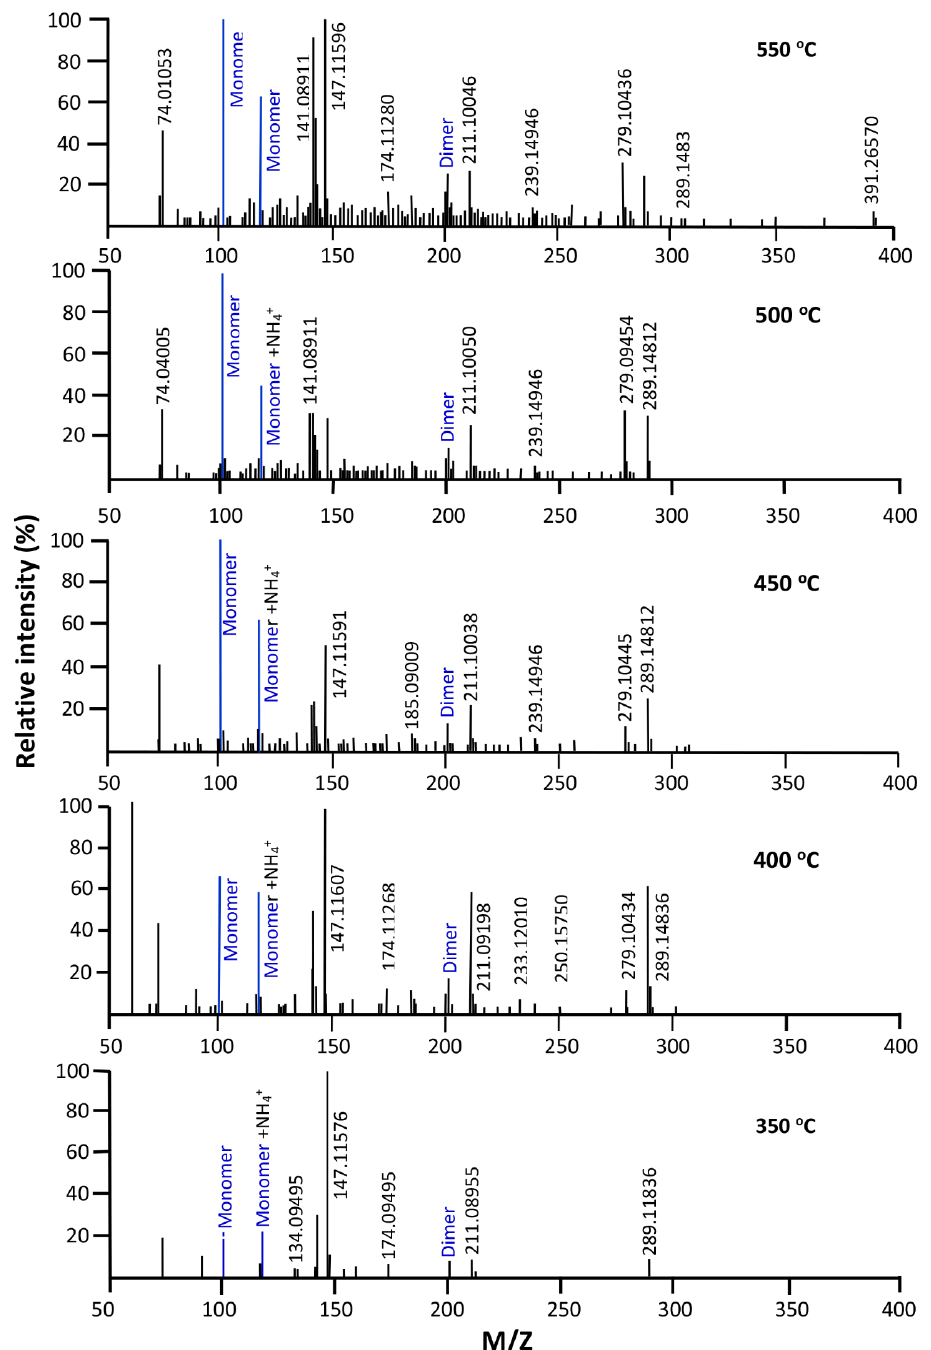
Figure 8. DART-Tof-MS spectrum of the isothermal decomposition of PMMA obtained in gas nitrogen at 350, 400, 450, 500 and 550 °C.